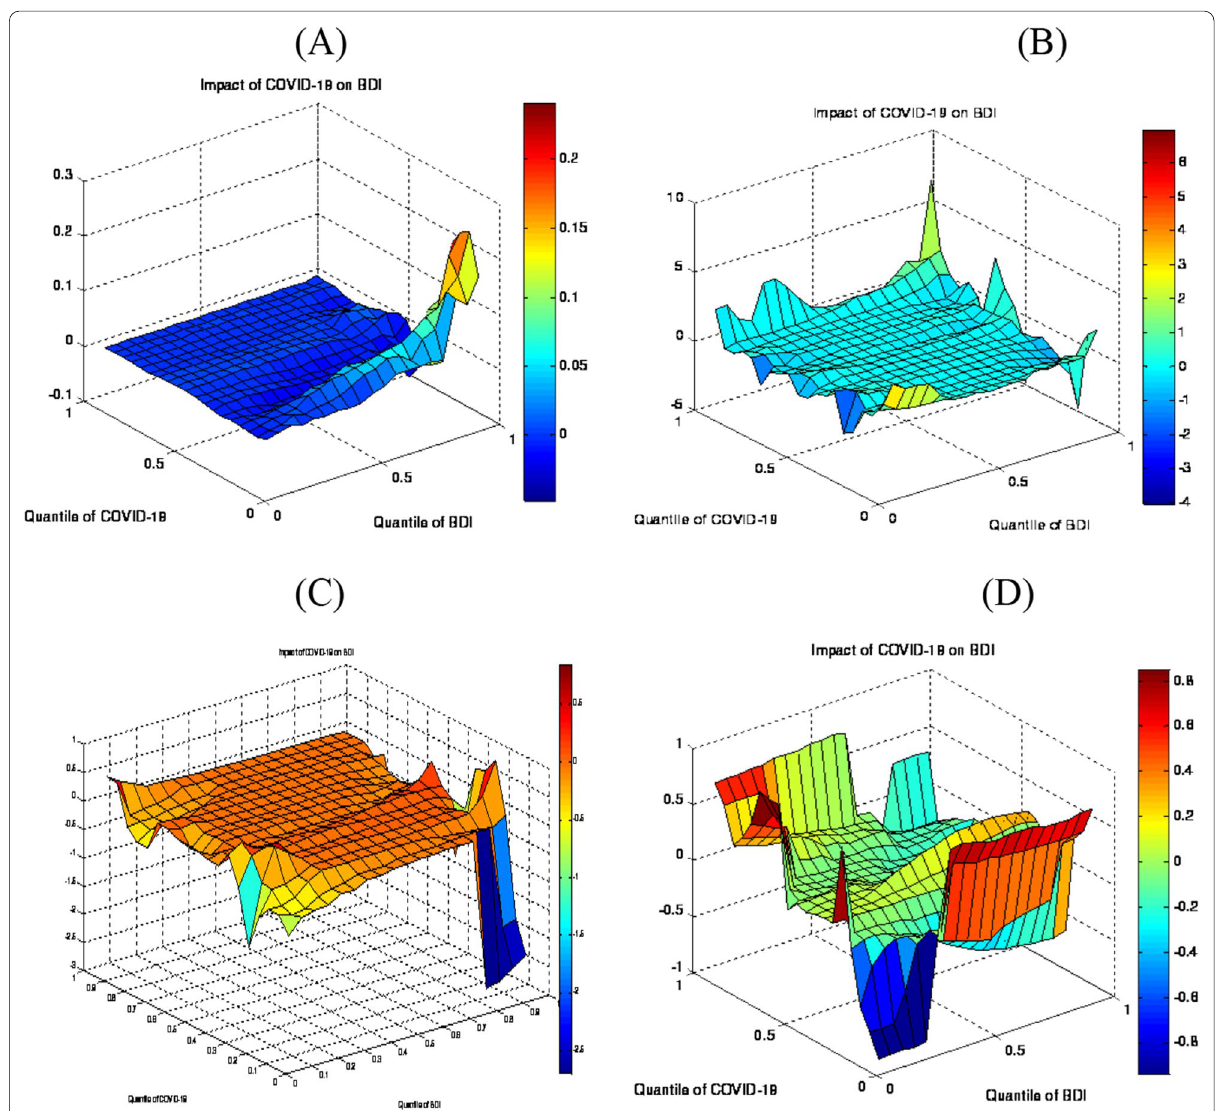
Fig. 1 Slope coefficient of QQ estimates. Note : the quantiles of COVID-19 are exhibited on the x-axis and BDI on the